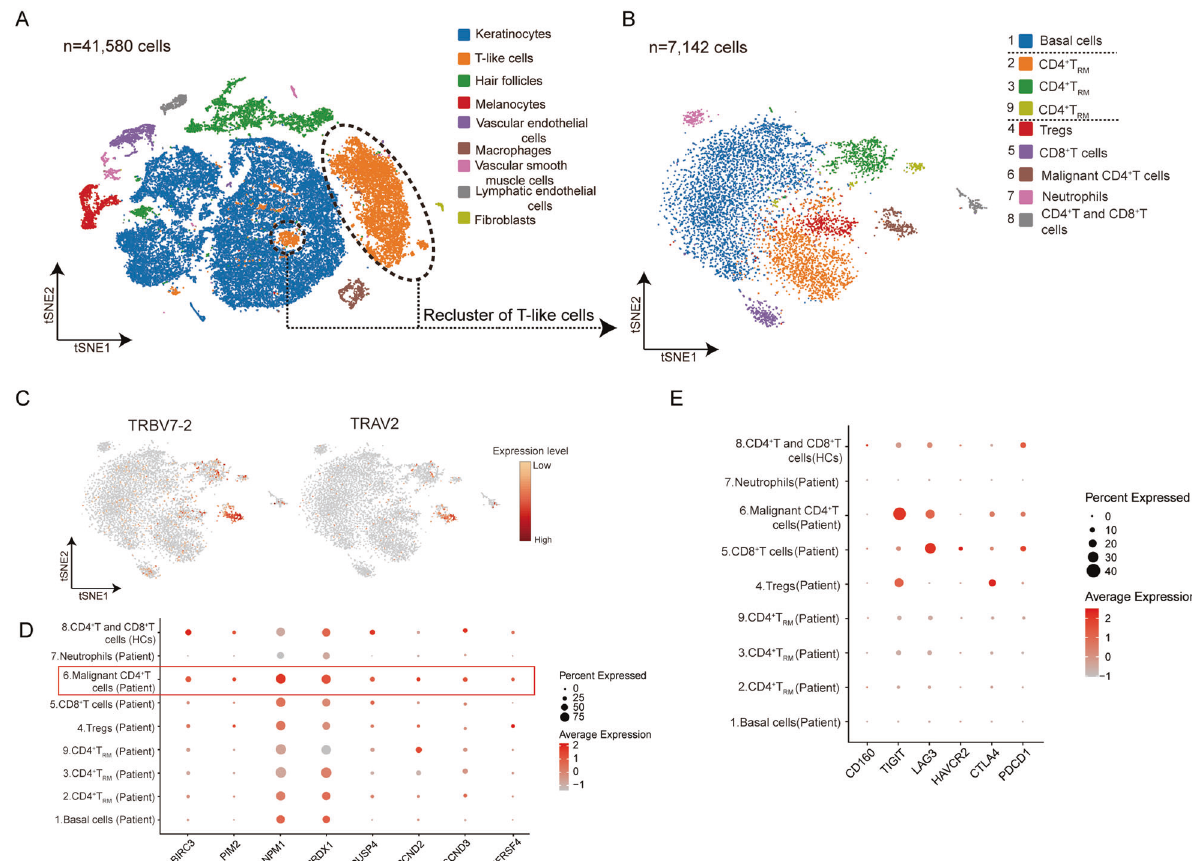
Fig. 2 Identi fi cation and transcriptional characteristics of malignant CD4 + T cells and tumor microenvironment in skin tissues. A t-SNE visualization of skin scRNA-seq pro fi le showing the formation of nine main clusters. B Sub-clustering of skin T-like cells from the SS patient and HCs, showing the formation of nine main clusters. C TRBV7-2 and TRAV2 showing higher frequency in cluster 6 from skin T-like cells in the SS patient. D Dot plot showing the expression of selected cell-cycle, proliferation, survival, and T-cell activation associated genes in each cluster of skin T-like cells from the SS patient and HCs. E Dot plot showing the proportion of cells expressed co-inhibitory receptors in each cluster of skin T-like cells from the SS patient and